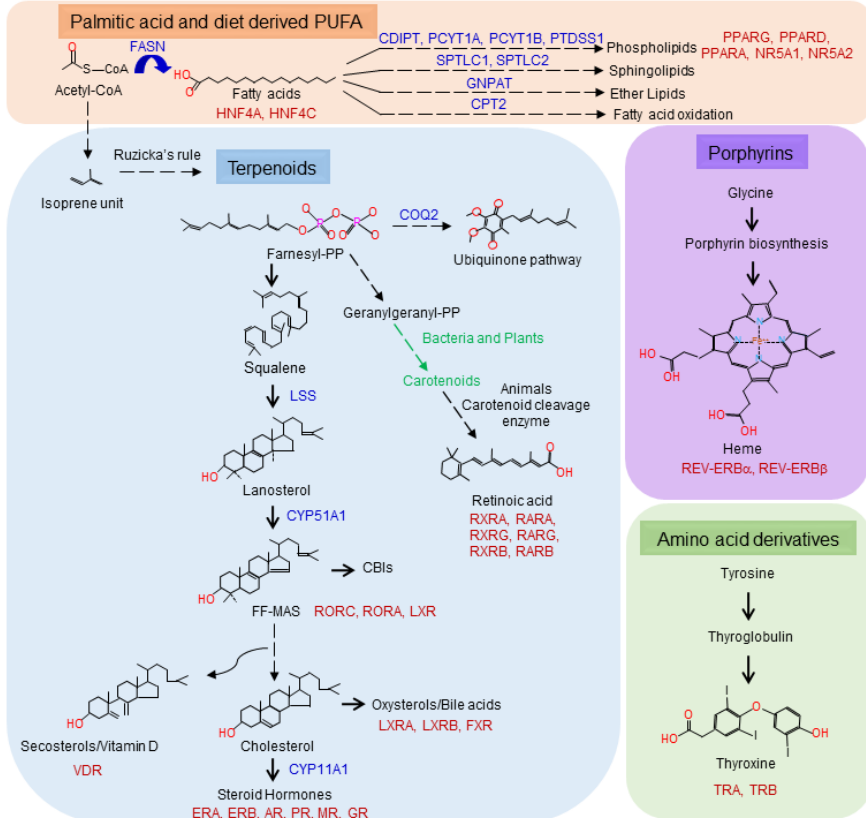
Figure 3. The biosynthetic routes for the known sources of human NHR ligands. Fatty acids (orange) and terpenoids (blue) are generated from acetyl-CoA. Fatty acids can be further modified into phospholipids, glycerolypids, sphingolipids, ether lipids and fatty acid oxidation products. Acetyl-CoA is used to generate the isoprene units for terpenoid biosynthesis. Mammals will generate farnesyl and geranylgeranyl pyrophosphate, dolichol (not shown), ubiquinone and cholesterol. Bacteria and plants utilize geranylgeranyl pyrophosphate to generate carotenoids that can be used by animals to generate retinoic acid. Porphyrins are synthesized from glycine and thyroid hormones from tyrosine.